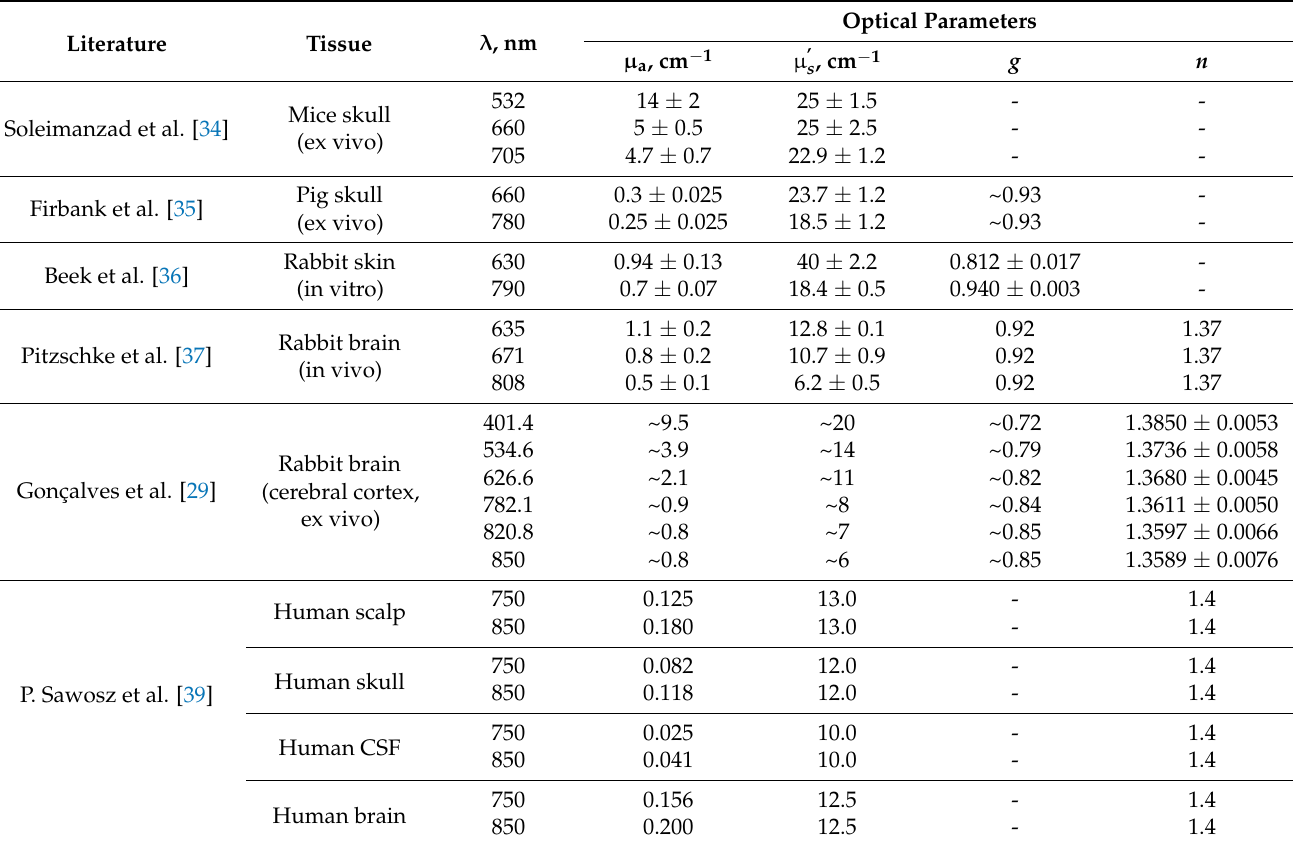
Figure 7. The measured total transmittance T t ( a ), diffuse reflectance R d ( b ), and collimated transmittance T c ( c ) of the rabbit brain samples were prepared with an average thickness of 0.5 mm. T t + R t + A = 1, where A is the relative absorbed intensity A = 1 − exp( − µ a d ). As µ a d was sufficiently small in our study, A ≅ 1 − [1 − µ a d ] = µ a d , T t = 1 − ( R d + R F ) − µ a d . Table 1. The obtained optical parameters were compared with the relevant data from the literature.